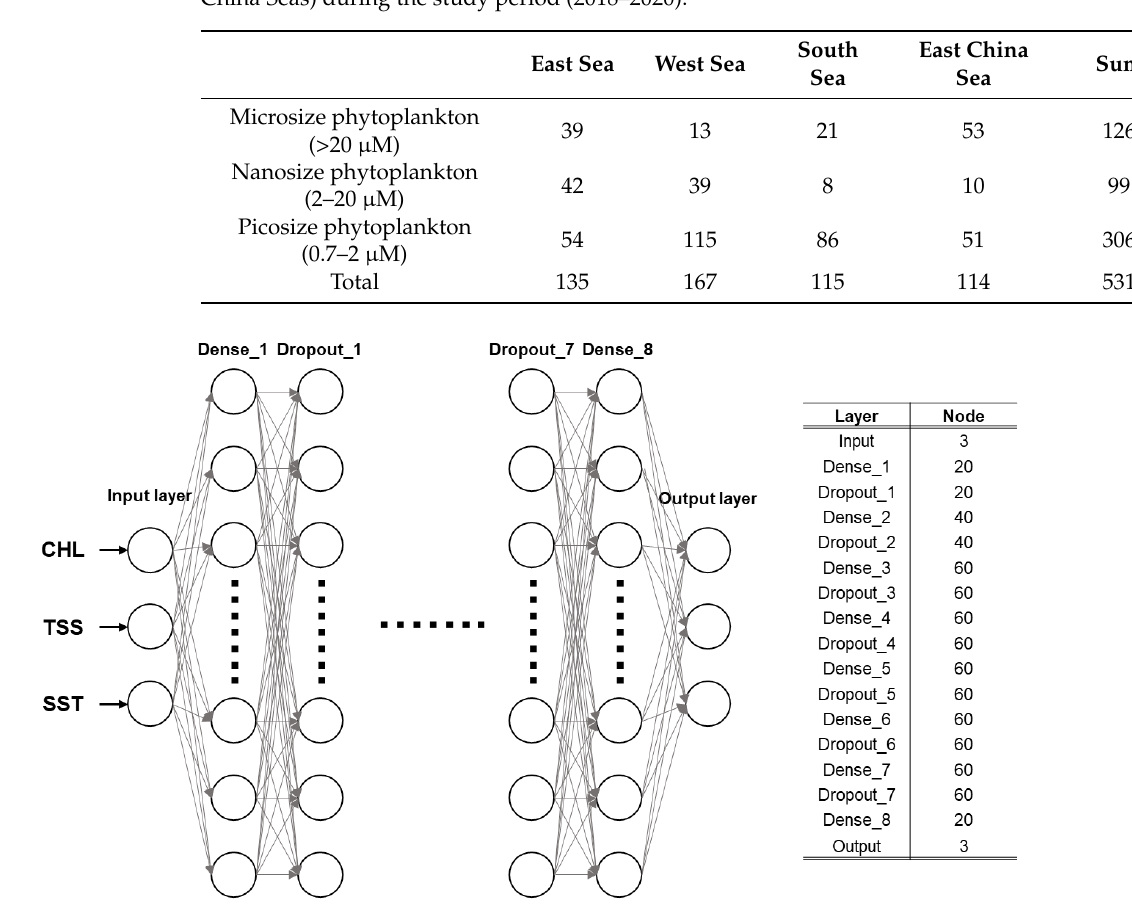
Table 1. The number of dominant-sized phytoplankton (ground truth data for training DNN-based model) which appeared at field observation stations in each sea area (East, West, South, and East